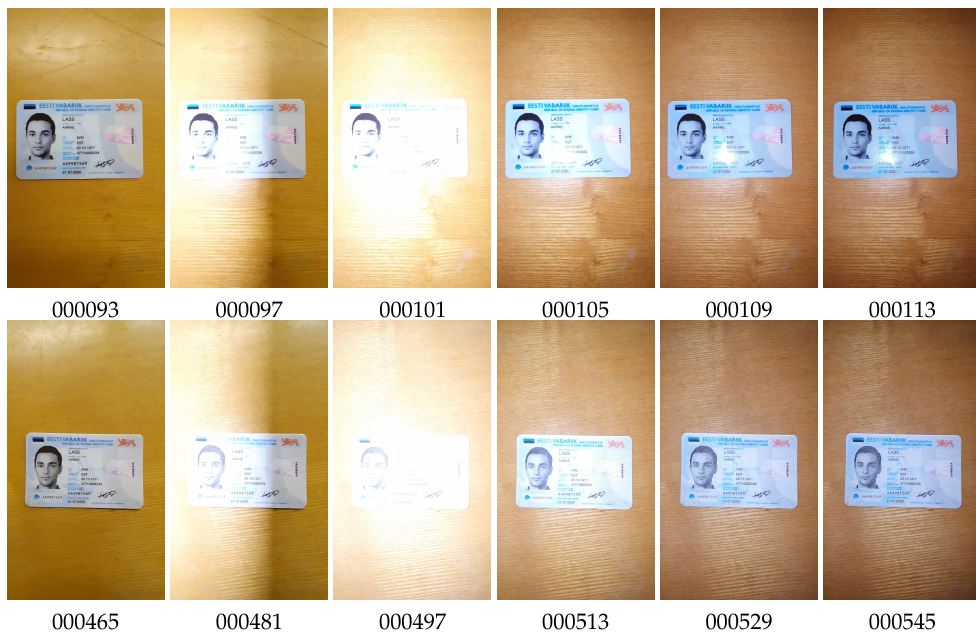
Figure 6. Frames with reflections caused by a flashlight for a laminated document, clip est_id/04.or0004 ( top ), and unlaminated document, clip est_id/04.cc0009 ( bottom ).